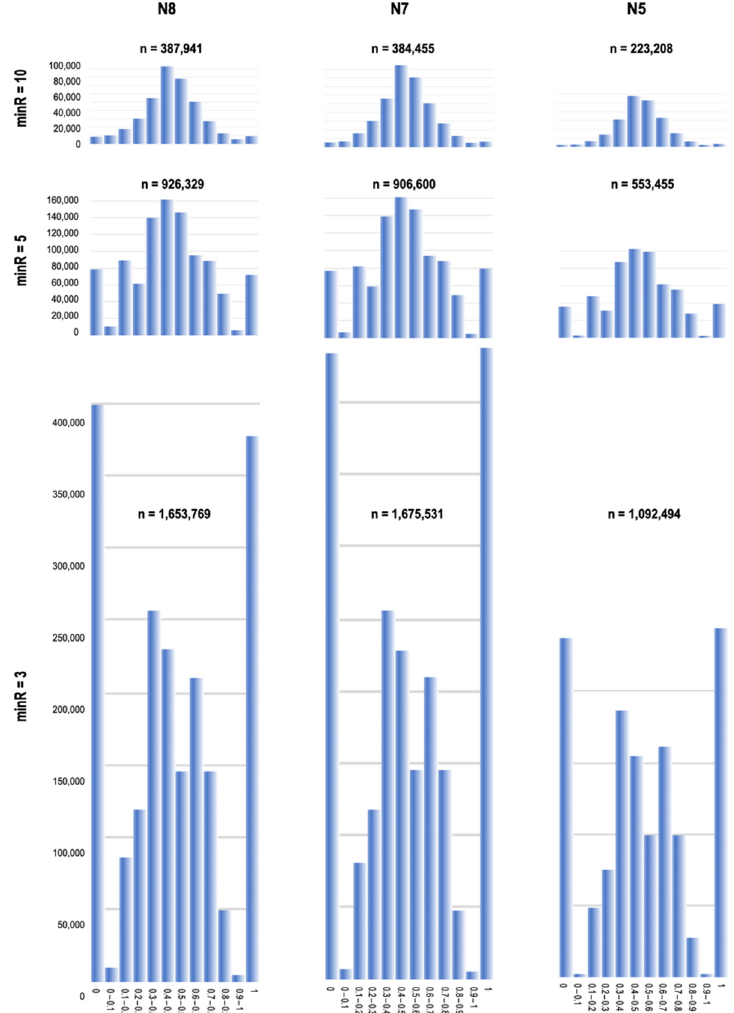
Figure 4. Histograms representing the distribution of scVAF RNA at minR = 10 (top), minR = 5 (middle), and minR = 3 (bottom) for all the heterozygous SNVs in N8, N7, and N5. The bin width (x-axis) is 0.1; bin intervals are indicated in the middle of each plot. The y-axes show the numbers of VAF RNA measurements in the individual cells. The total number of VAF RNA estimations (n, across all the cells per group) is shown at the top of each histogram. The histograms are scaled in regard to the number of cells. Across the entire dataset, at minR = 10 and minR = 5, the majority of SNVs showed bi-allelic expression centered around a VAF RNA value of 0.5 (0.4 < VAF RNA < 0.6). In contrast, at minR = 3, the majority of SNVs presented with strict monoallelic expression (VAF RNA = 0 or 1). The VAF RNA distributions showed remarkable similarity across the three individuals (N8, N7, and N5).